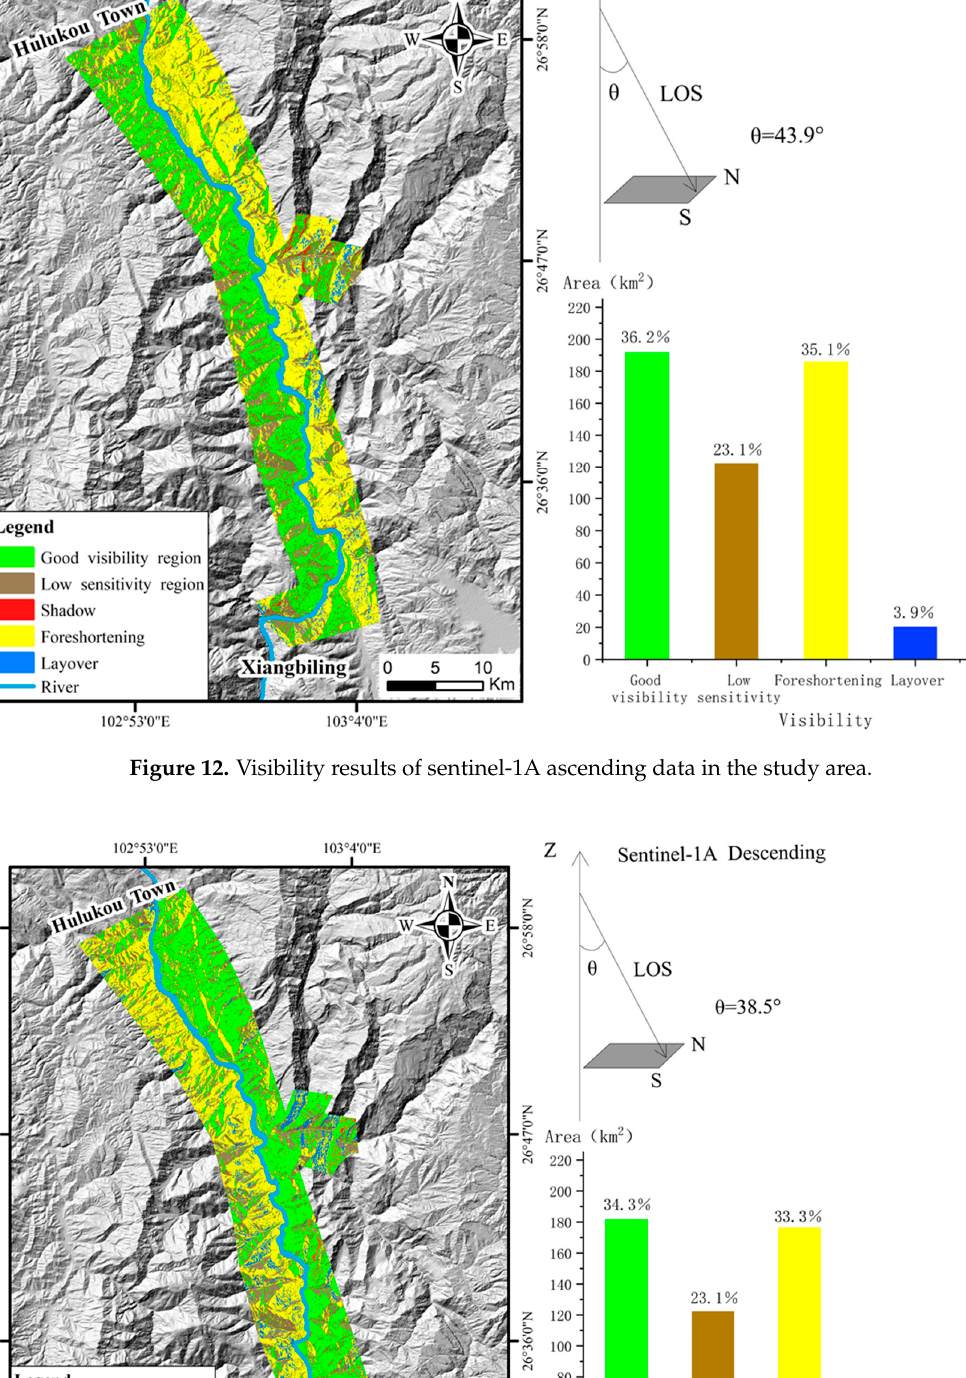
Figure 11. Flowchart of SBAS method.